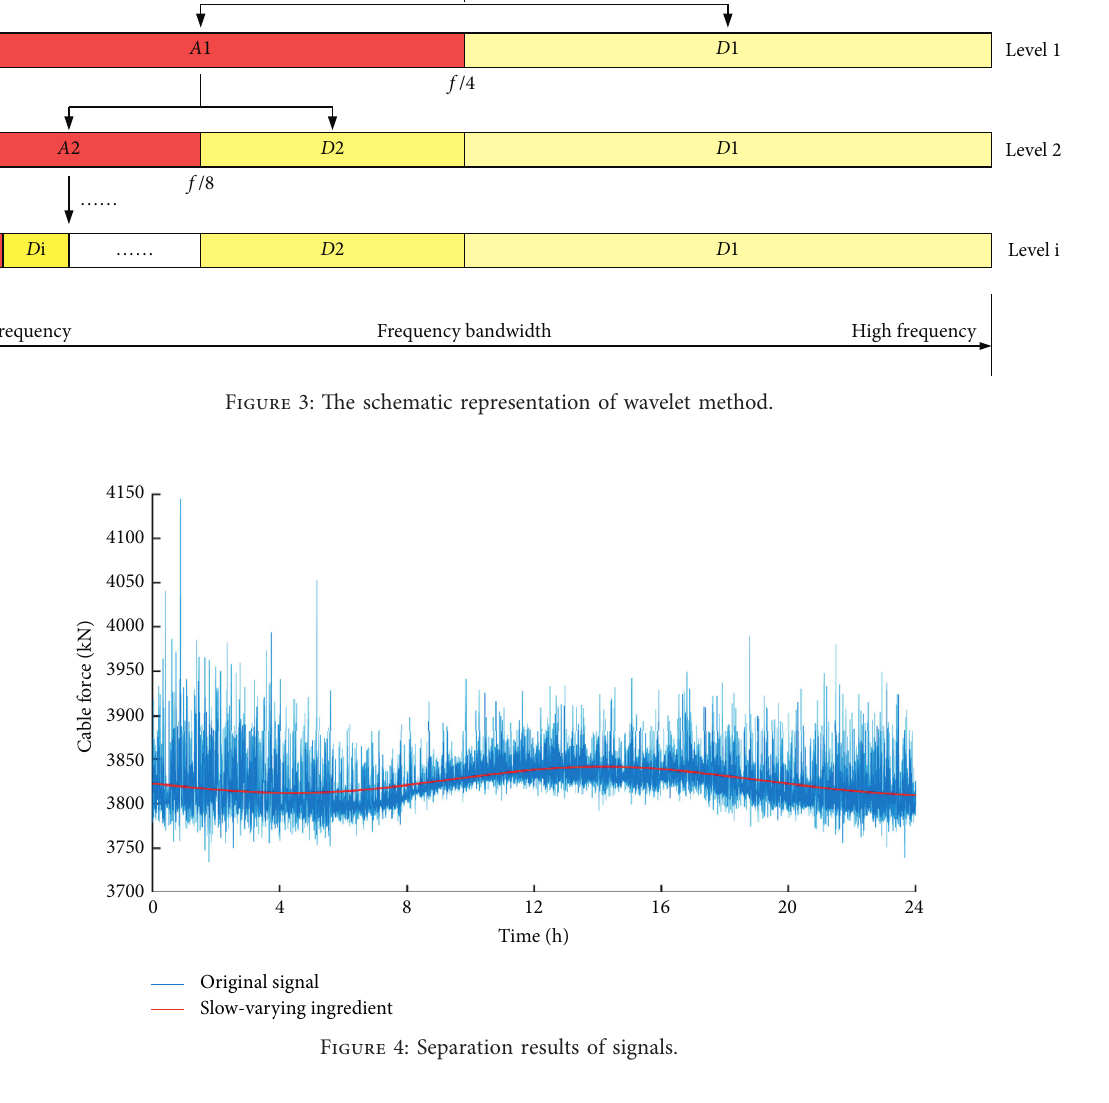
Figure 4: Separation results of